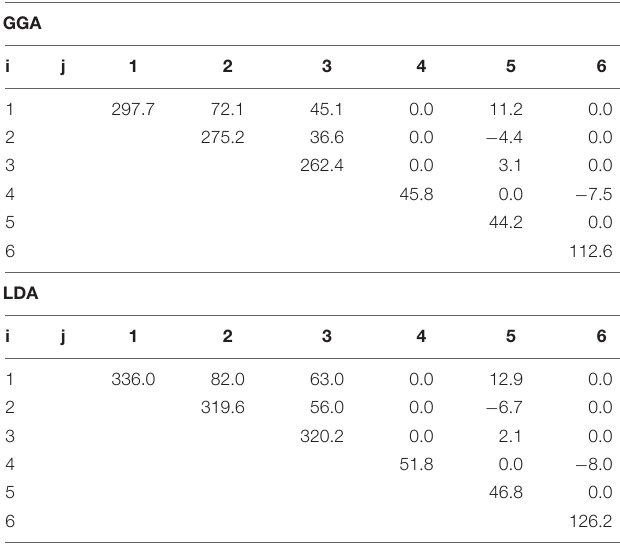
TABLE 3 | Seismic velocity and anisotropy of hydrous minerals and a hypothetical bulk rock. Mineral AV P (%) max AV S